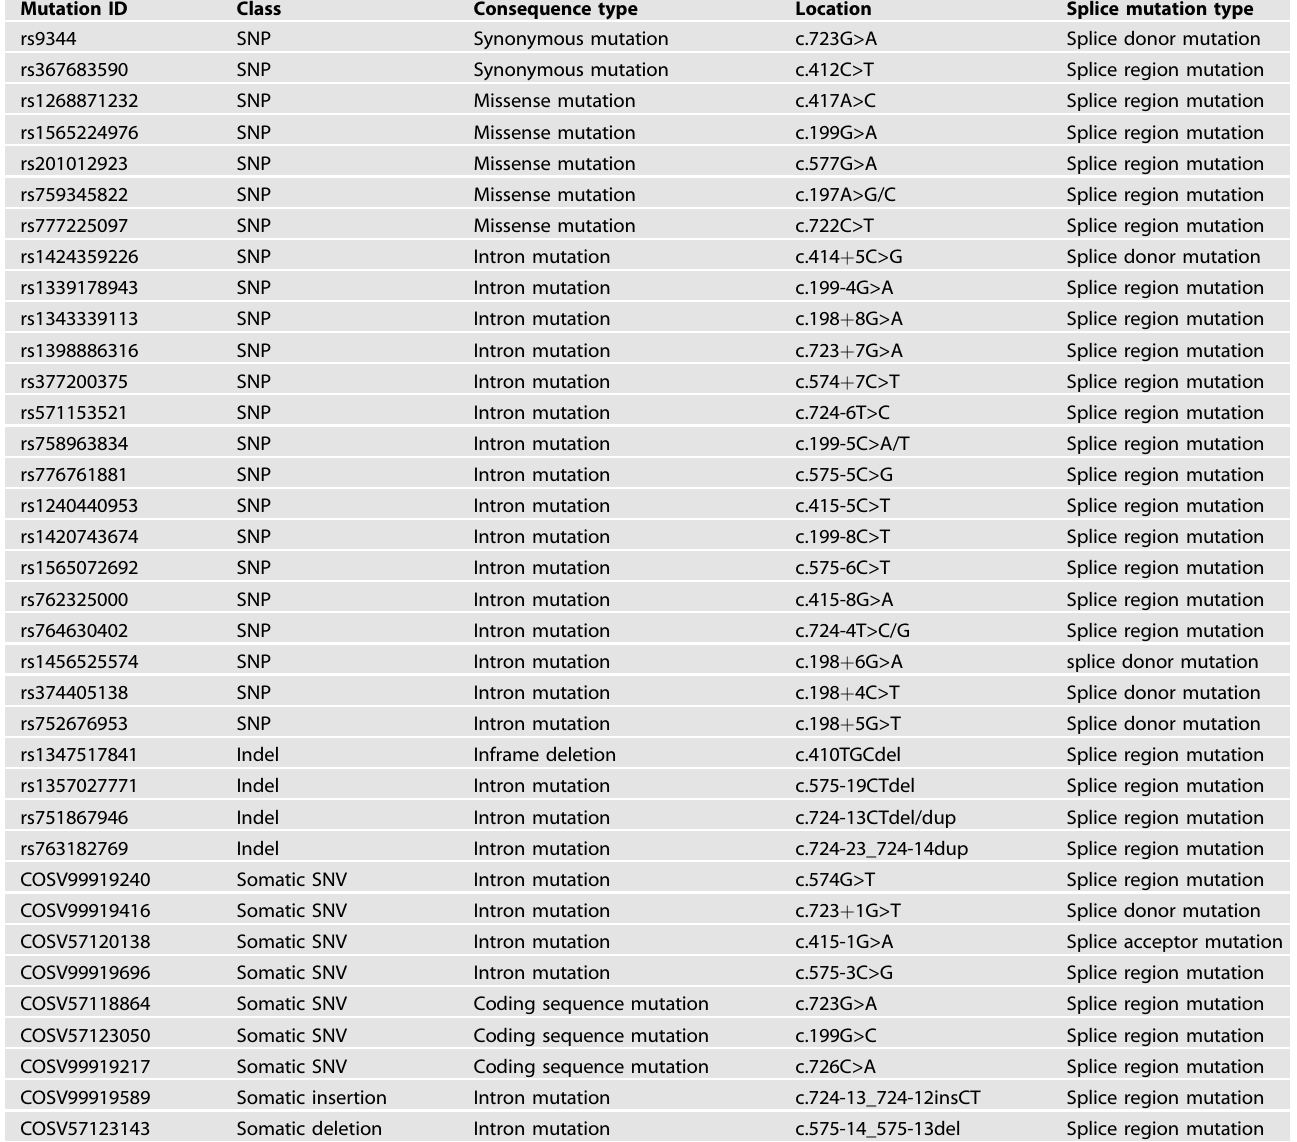
Table 3. Some splice mutations regulate splicing of